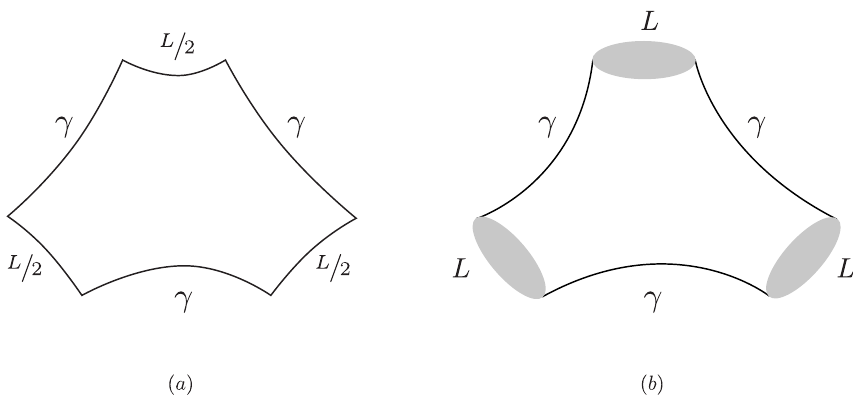
Figure 5 . (a) A hexagon with geodesic edges that meet orthogonally at each vertex. This is a special vertex with three edges of length L/ 2 and three edges of length γ . (b) Gluing two such hexagons across the length γ edges we obtain a pants diagram, the string vertex with three equal boundaries that are geodesics of length L